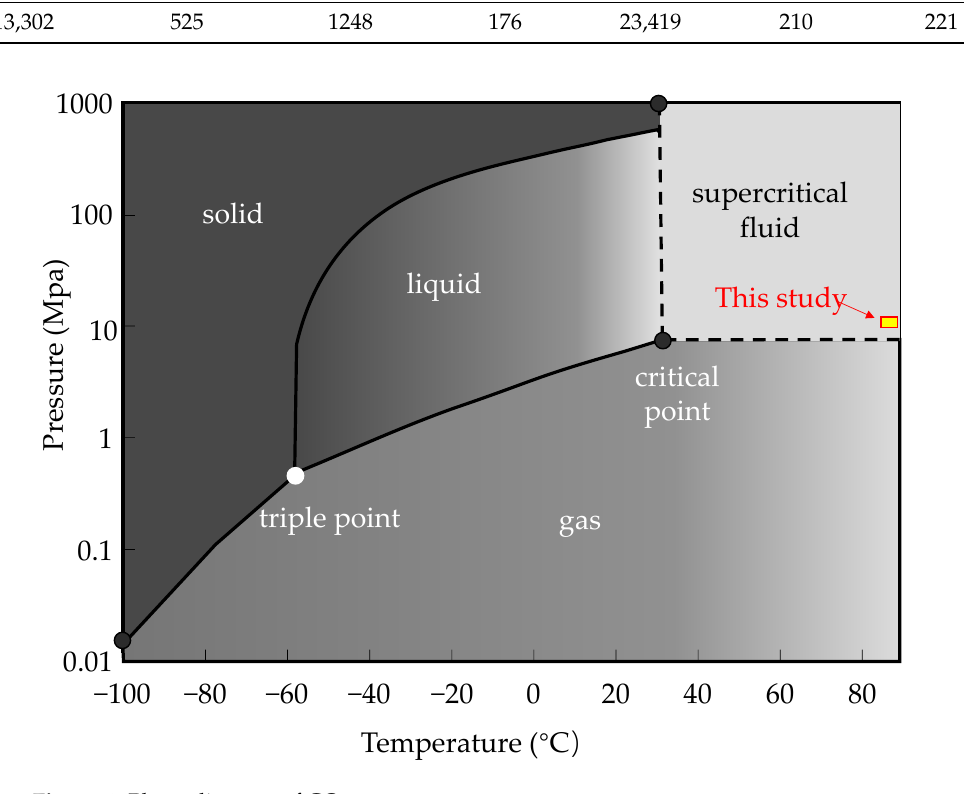
Figure 4. Phase diagram of CO 2.